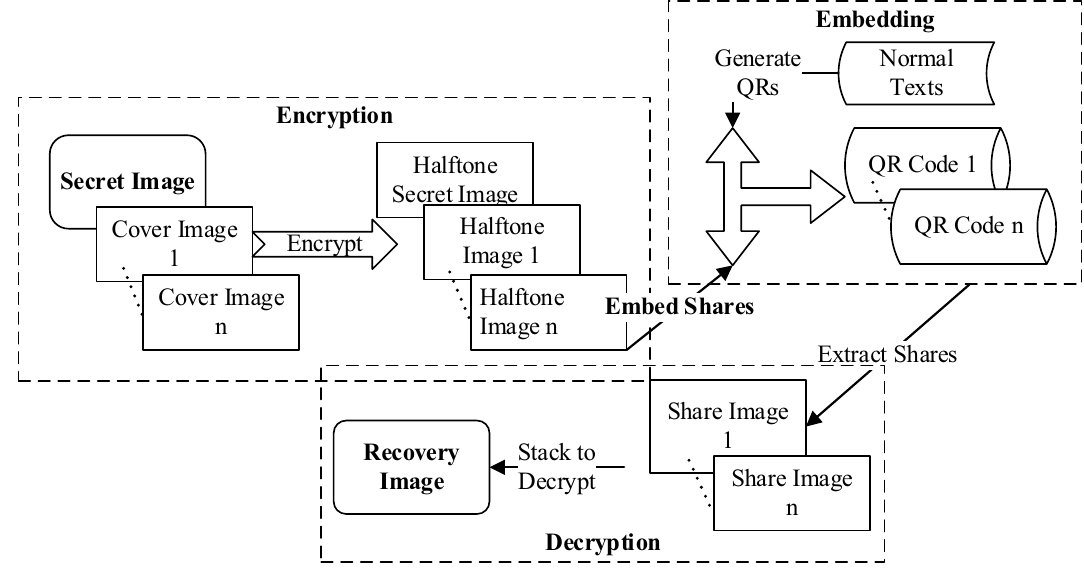
Figure 1. The encryption and decryption architecture of the proposed